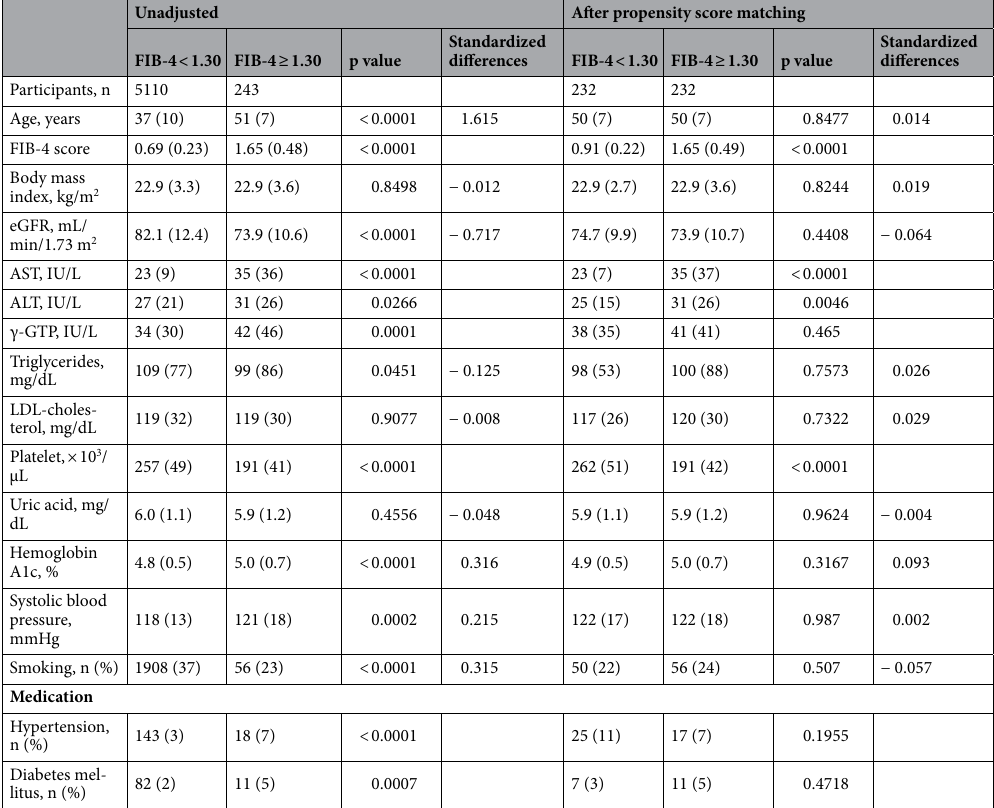
Table 1. Baseline characteristics of participants. Propensity score matching (1:1) was performed by covariates such as age, body mass index, eGFR, triglycerides, LDL-cholesterol, hemoglobin A1c, uric acid, systolic blood pressure, and smoking habit. Smoking: participants with daily habit of smoking. Data are expressed as mean (standard deviation), except smoking and medication for hypertension and diabetes mellitus. ALT alanine transaminase, AST aspartate transaminase, eGFR estimated glomerular filtration rate, γ-GTP gamma-glutamyl transferase, LDL low-density lipoprotein. P value was calculated by Student’s t-test or χ 2